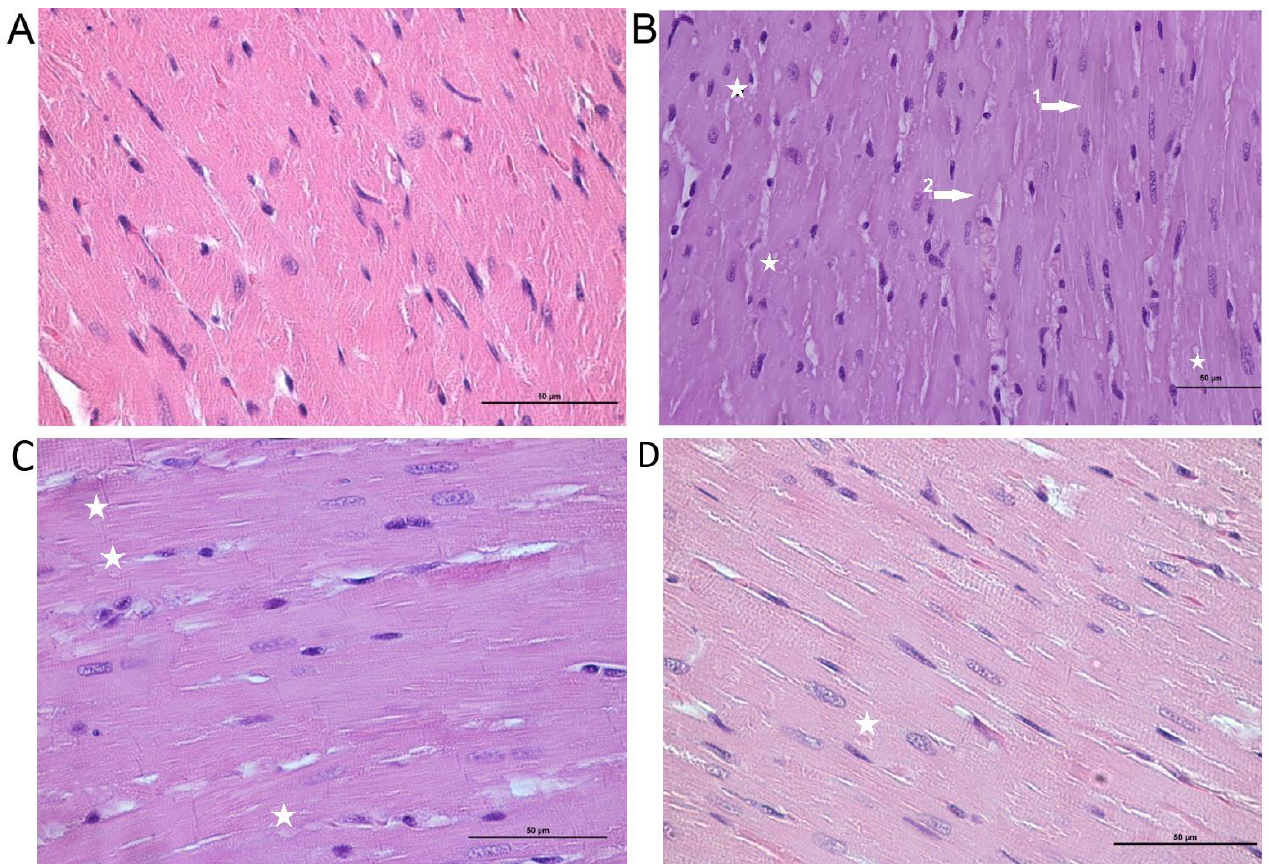
Figure 5. Cardiac muscle tissue. ( A ) — control group, normal structure. ( B ) — DOX group, dystrophic changes in cardiomyocytes: loss of striation (1,2 arrows) and vacuolization of the cytoplasm (stars). ( C ) — NR+DOX group, minimal alterative changes. ( D ) — NR/NR+DOX group, minimal alterative changes. Stained with hematoxylin – eosin, × 50. DOX represents doxorubicin group; NR+DOX represents nicotinamide riboside + doxorubicin group — combined mode ; and NR/NR+DOX represents nicotinamide riboside/nicotinamide riboside + doxorubicin group — preventive mode . The results for Mallory’s histochemical stain morphometry are shown in Figure